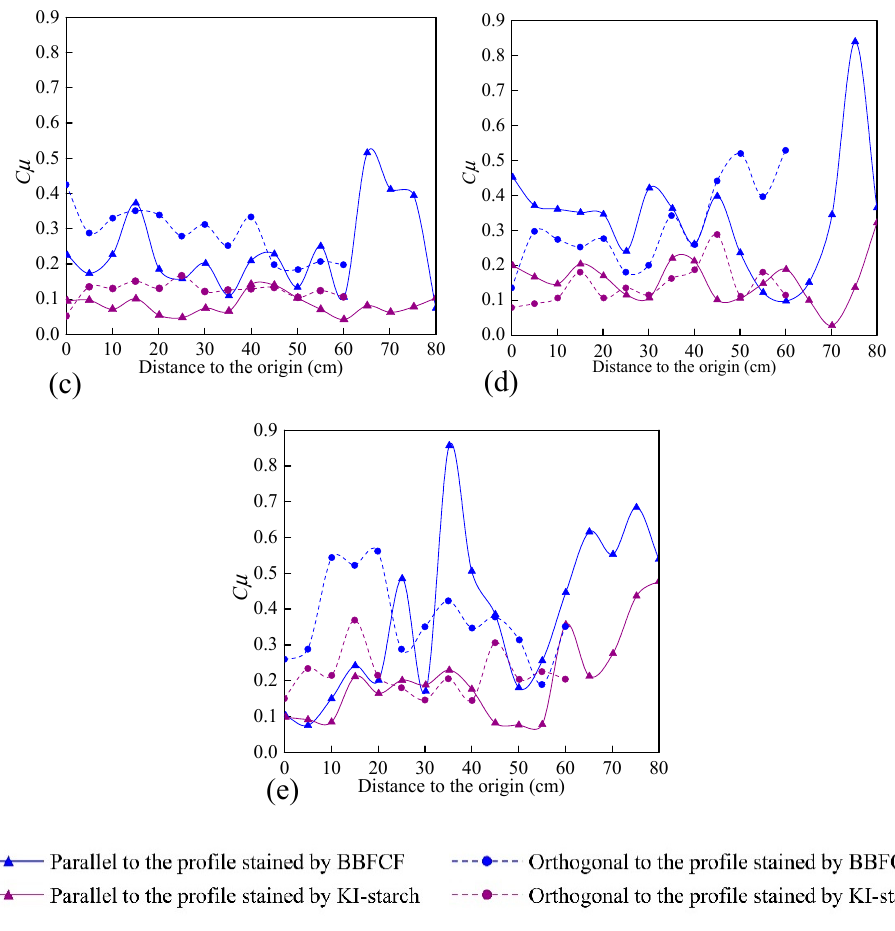
Figure 8. Nonuniformity coefficient ( C µ ) of infiltration depth for the ( a ) bottom–, ( b ) lower–, ( c ) mid–, ( d ) upper–, and ( e ) top–slope plots.